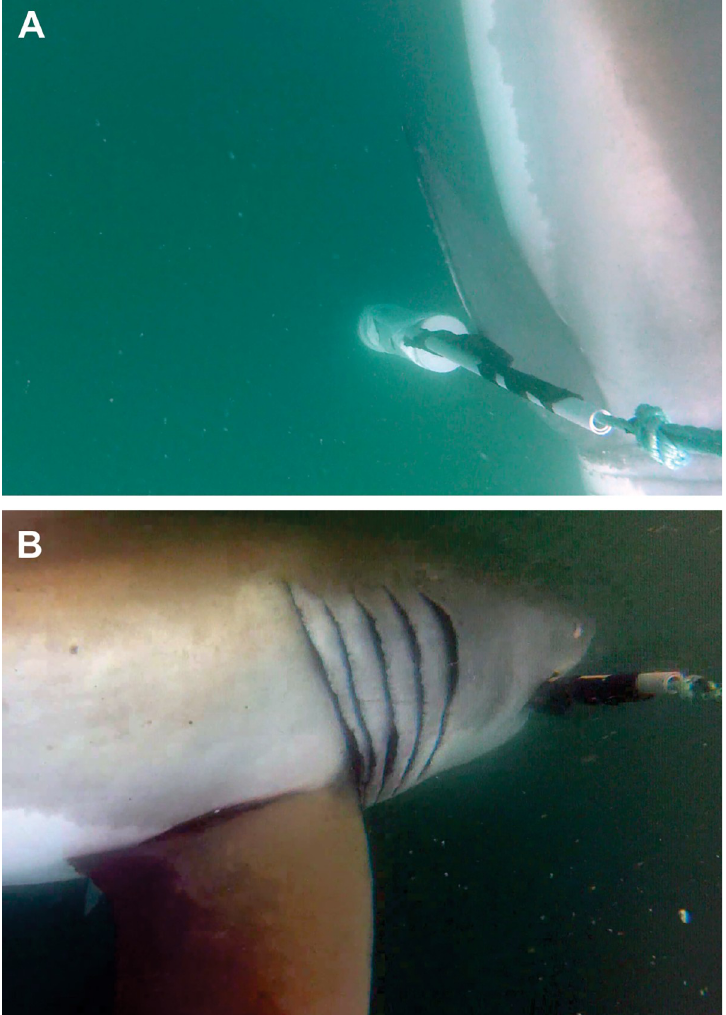
Fig 3. Screenshots of C . carcharias encountering an active ESDS: (A) C . carcharias interacting with the bait (Type 1 interaction); (B) C . carcharias biting the bait (Type 2 interaction).